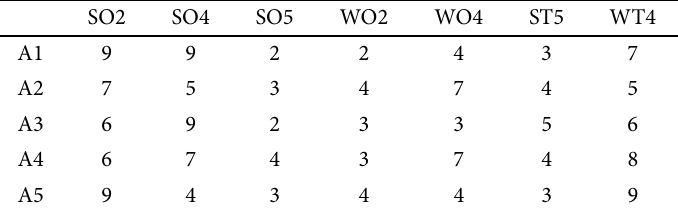
Table 10. The fuzzy number of alternatives by decision